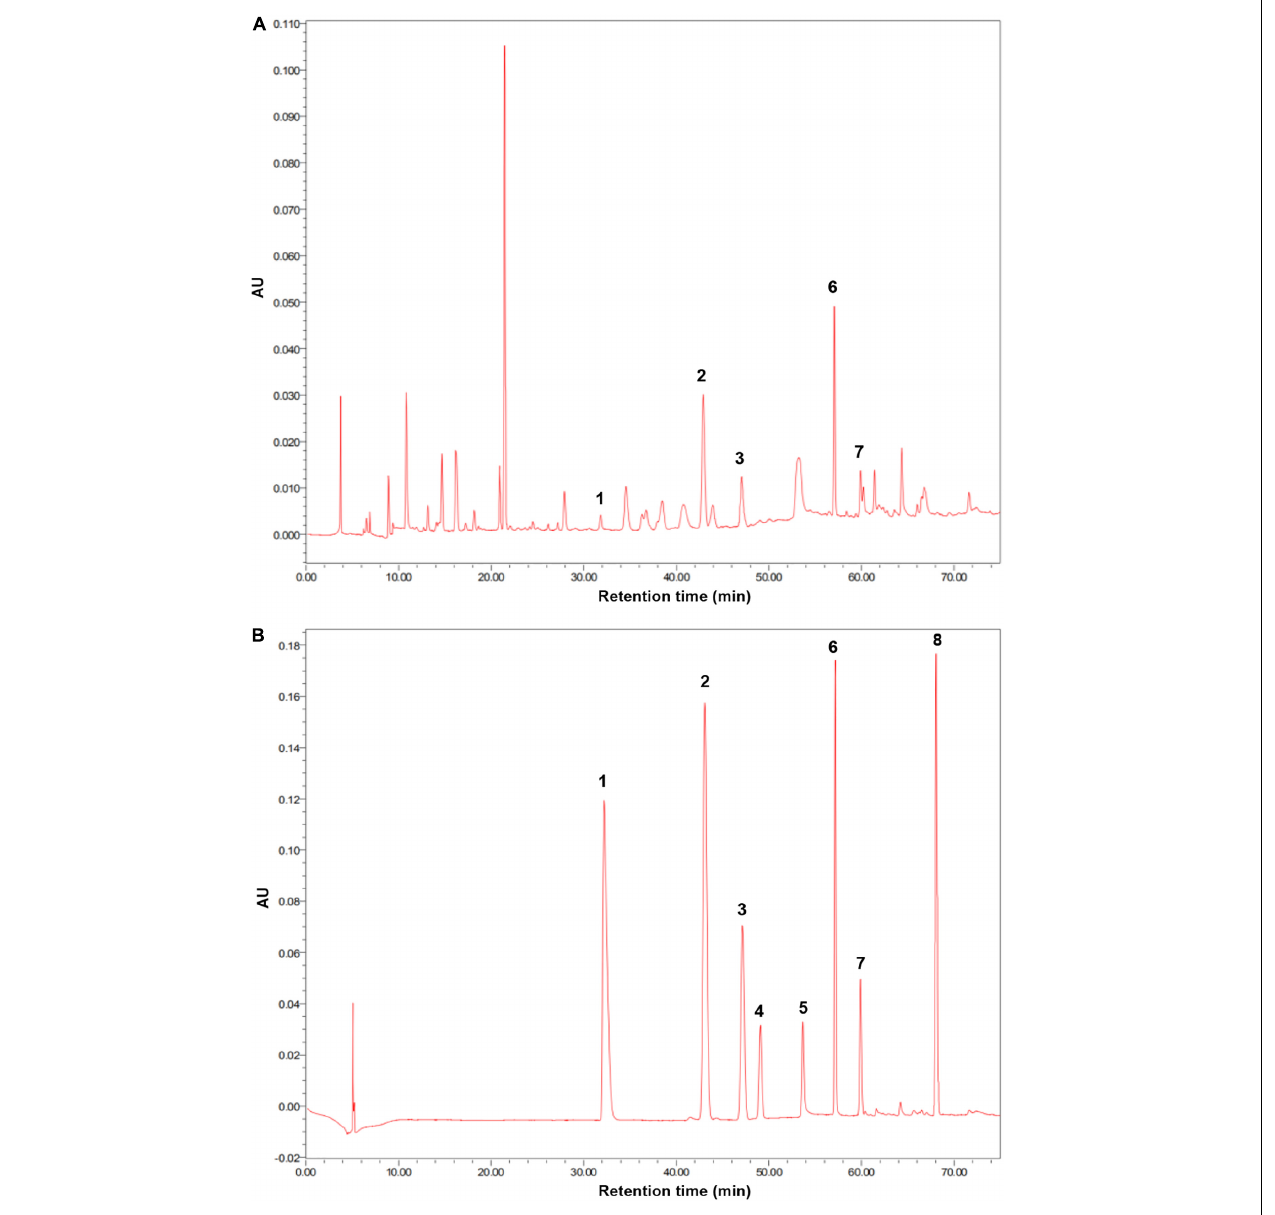
FIGURE 1 | (A) High-performance liquid chromatography (HPLC) chromatogram of extracts obtained from cucumber continuous cropping soil was used in this experiment. (B) HPLC chromatogram of standard phenolic acids. (1) p -coumaric acid; (2) p -hydroxybenzoic acid; (3) vanillic acid; (4) syringic acid; (5) vanillin; (6) ferulic acid; (7), benzoic acid; (8) cinnamic